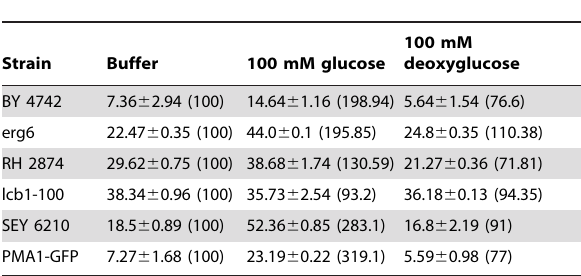
Table 2. Pma1 activity in situ (nmol P i /min/mg total cell protein, n =3 6 SD) after 15-min incubation of S. cerevisiae whole cells with 100 mM glucose or 100 mM deoxyglucose. The change of activity in % of initial activity is given in